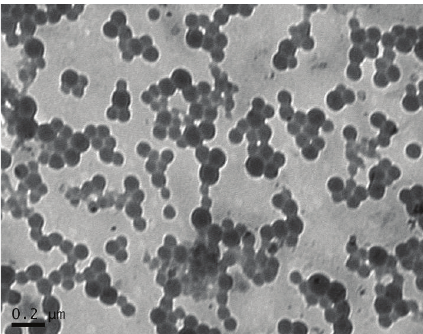
Figure 1: TEM image of GCV-BSA-NPs. GCV-BSA-NPs were nearly spherical, about 100–130 nm in diameter.